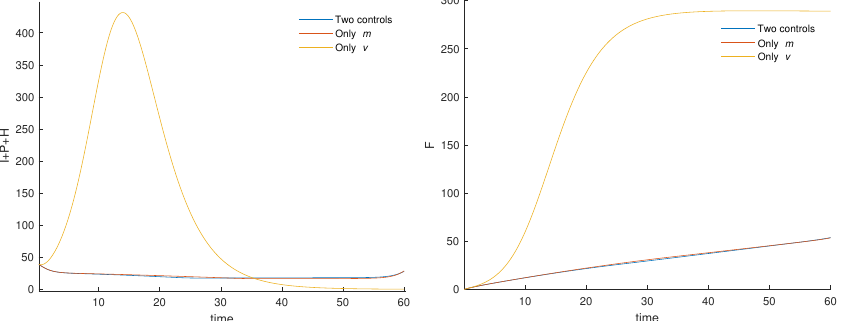
Figure 11. Comparison of the solution of the FOCP (4)–(7) with the fractional-order derivative α = 0.99, considering the two controls with the two other cases where there is only one control used. (left) Variation of infected individuals I + P + H . (right) Evolution of fatalities F